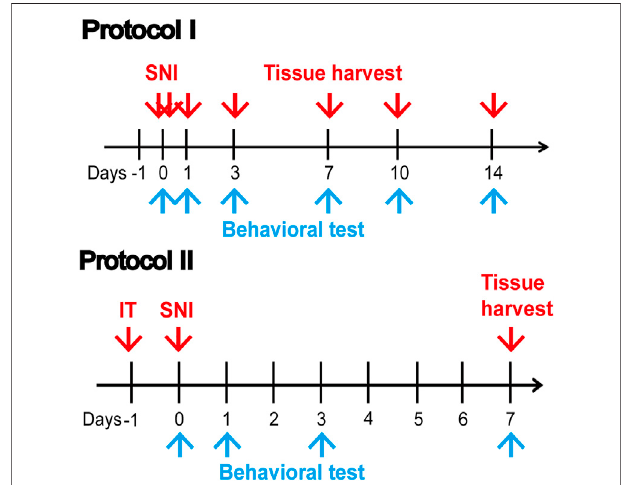
FIGURE 1 | Illustrative diagram of the experiment. Protocol I: Behavioral tests were performed on days 0, 1, 3, 7, 10, and 14 post-SNI. Protein was removed from the L4-6 lumbar enlargement of the spinal cord for biological testsonday14post-SNI.ProtocolII:AdaybeforeSNI,Ad-SIRT2orAd- control was injected intrathecally. Behavioral tests were performed on days 0, 1, 3, and 7 post-SNI. Tissue samples were harvested on day 7 post-SNI. SNI: spared nerve injury; IT: intrathecalinjection of SIRT2 adenovirus (Ad-SIRT2) or Ad-control; blue arrow: Behavioral test.